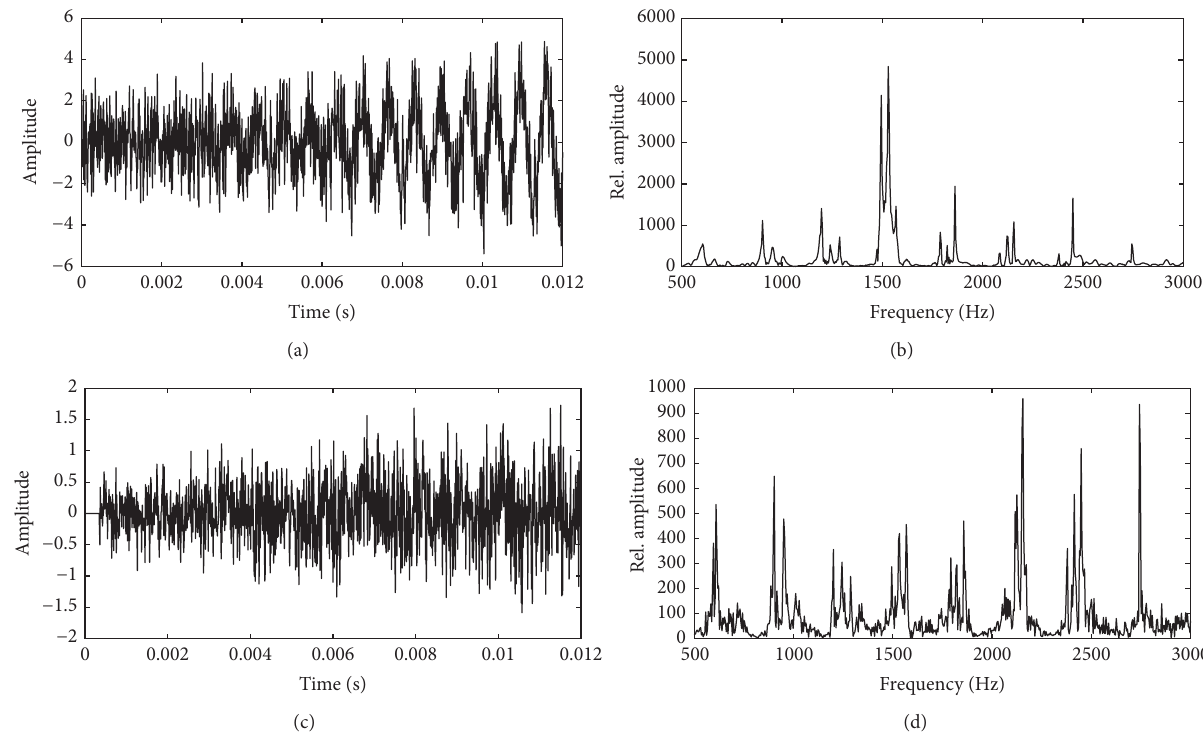
Figure 3: Simulation results of received signals in the single-receiver mode. (a) Time-domain waveform at the receiver 𝑆 1 , (b) frequency- domain waveform at the receiver 𝑆 1 , (c) time-domain waveform at the receiver 𝑆 2 , and (d) frequency-domain waveform at the receiver 𝑆 2